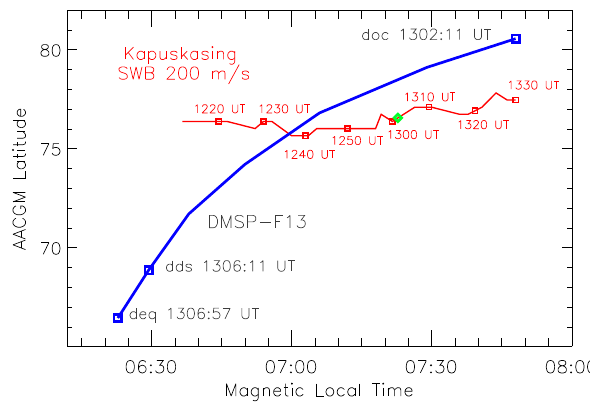
Fig. 2. An example boundary correlation from 1 April 2000. The blue line represents the path of DMSP-F13 with PPBs marked as blue squares (boundary type and UT of observation shown). The red line represents the path of the 200m/s threshold SWB for Ka- puskasing beam 11 (UTs of observations shown). The position of the SWB at the time of the OCB observation is indicated by the green diamond on the red